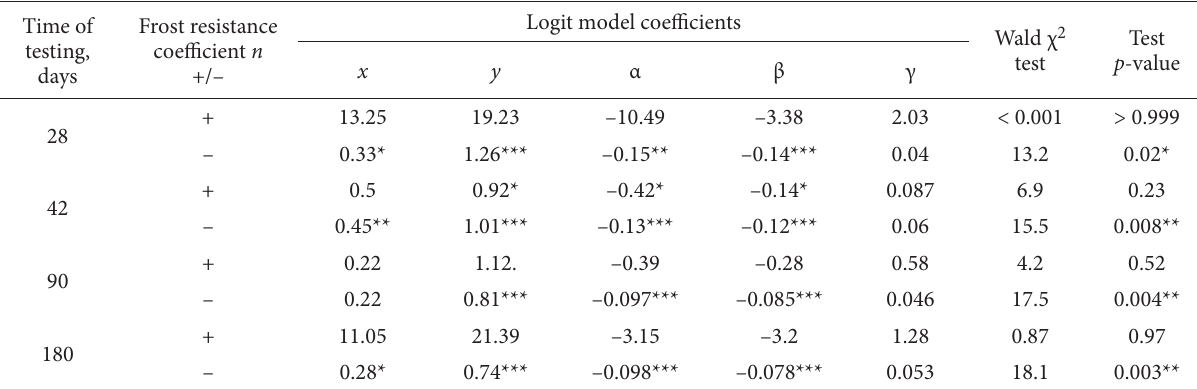
Table 4. Statistical coefficients of the logit model for soil-binder mixtures containing soil No. 1, tested after 28, 42, 90 and 180 days of hardening, with or without consideration of the frost resistance coefficient n , subject to the criterion of the mixture’s having a compressive strength in the range from 2.5 MPa to 5.0 MPa Time of